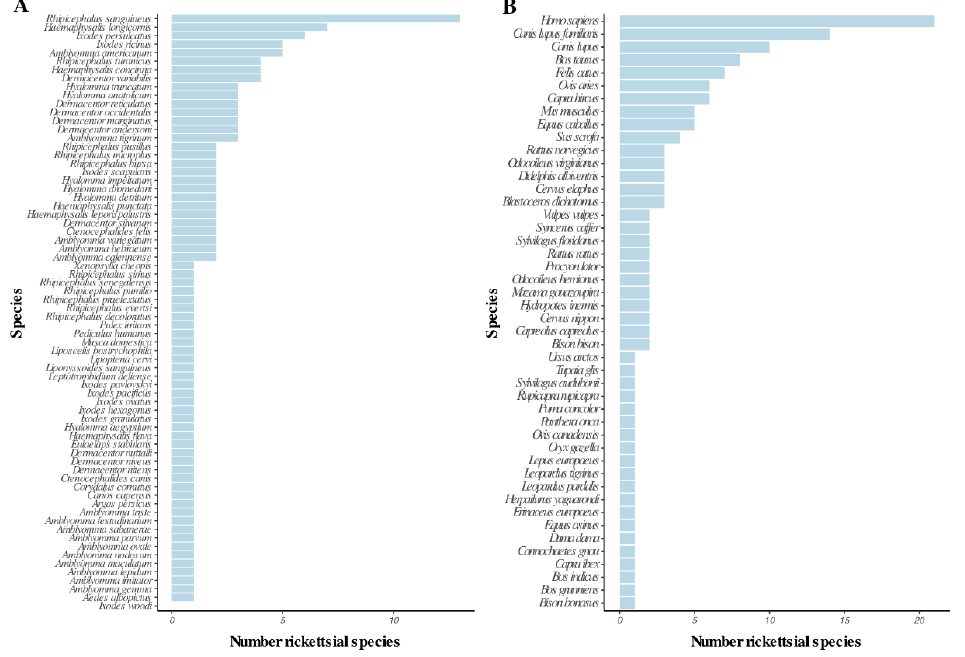
Figure 2. Number of rickettsial species by carriers: ( A ) arthropod species; ( B ) mammal and human species. Data from the EID2 database [20].